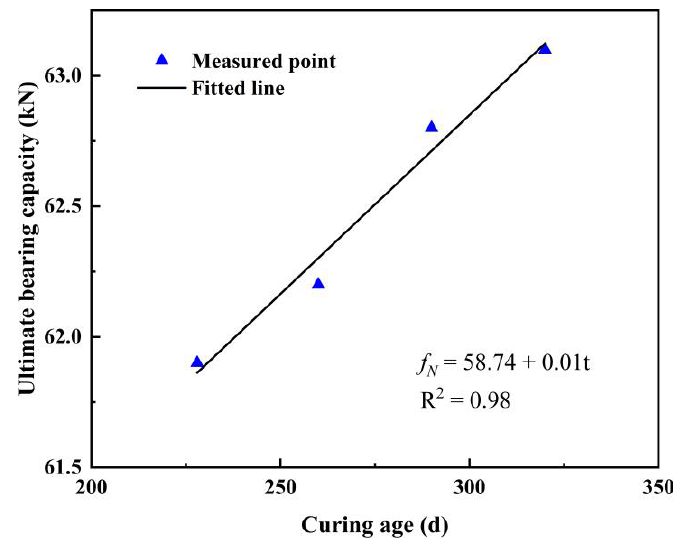
Figure 14. Ultimate bearing capacity curves at different maintenance ages.